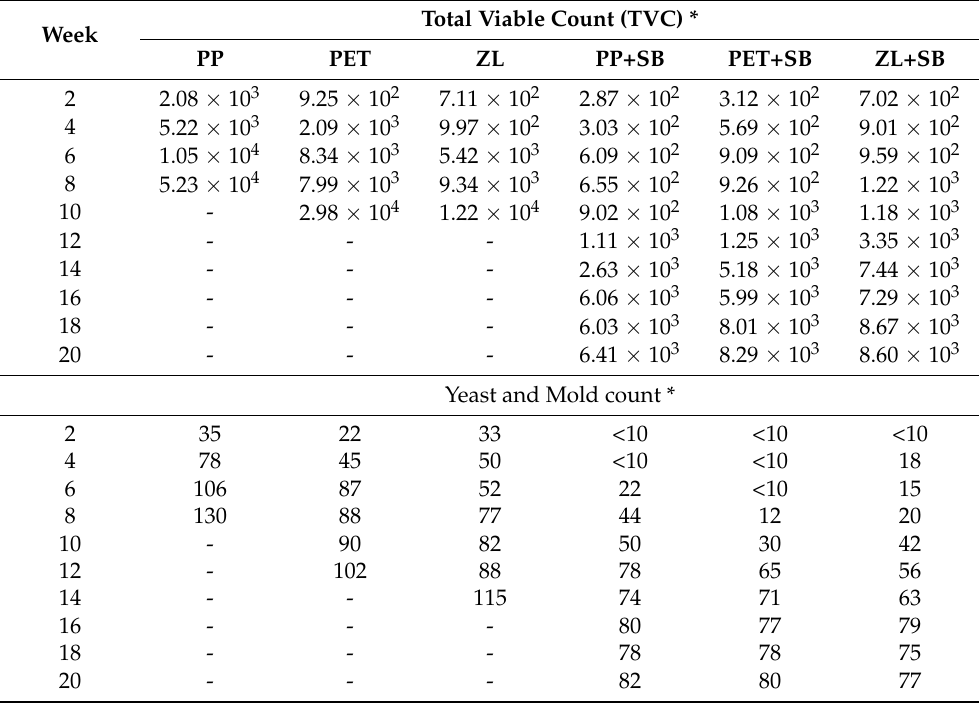
Table 4. Changes in total viable count (TVC) and yeast and mold of dried chili fish paste during storage at room